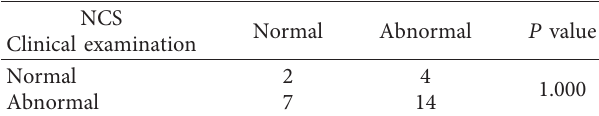
Table 7: Association between abnormal clinical examination and abnormal NCS.